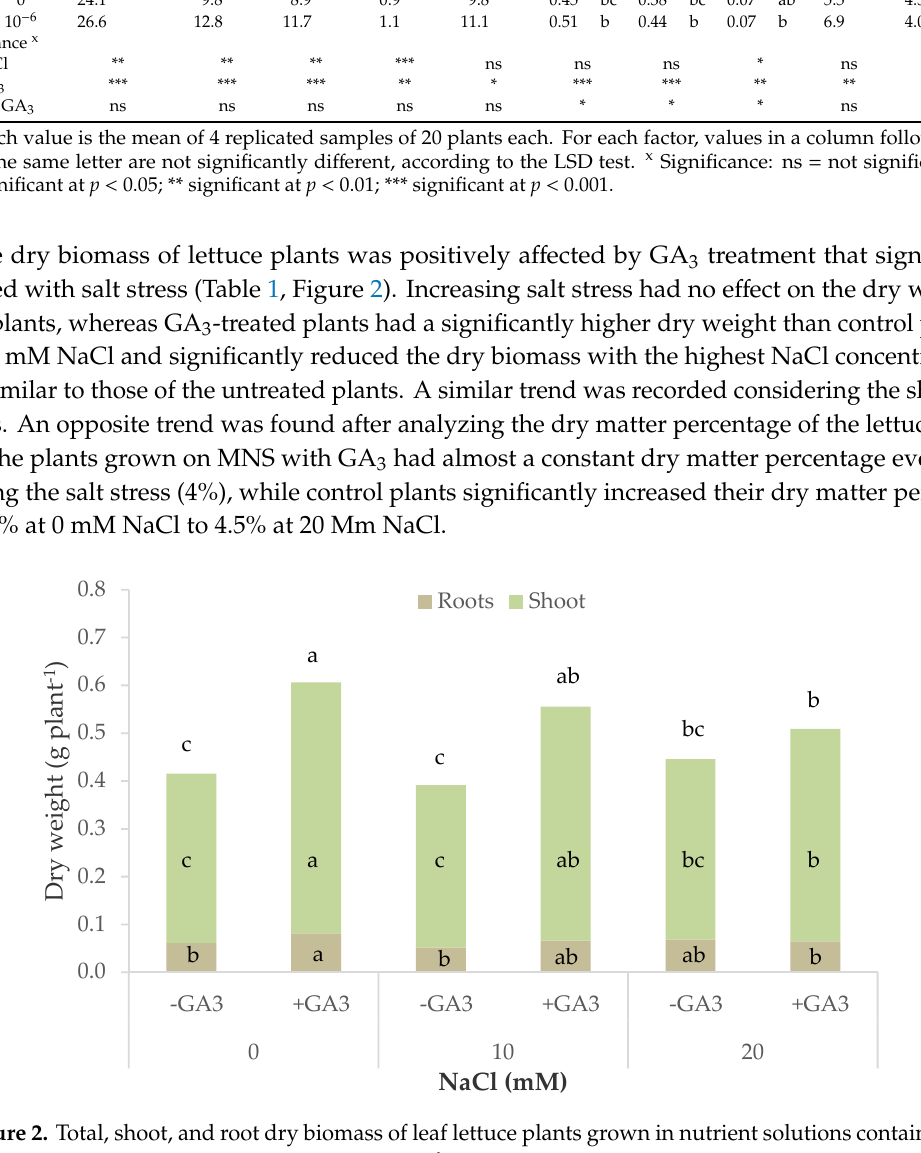
Figure 2. Total, shoot, and root dry biomass of leaf lettuce plants grown in nutrient solutions containing di ff erent levels of NaCl and gibberellic acid (10 − 6 M GA 3 ) (bars of the same color with di ff erent letters are significantly di ff erent at p < 0.05 according to the LSD test).